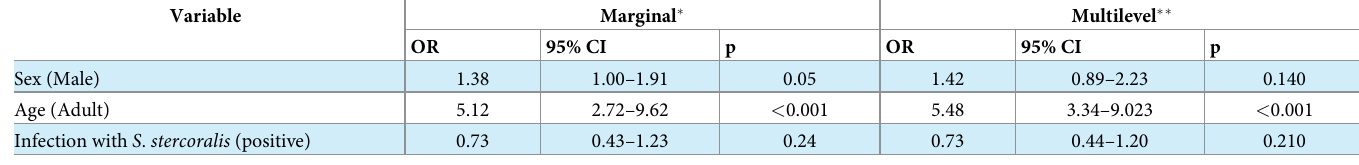
Infection with S . stercoralis